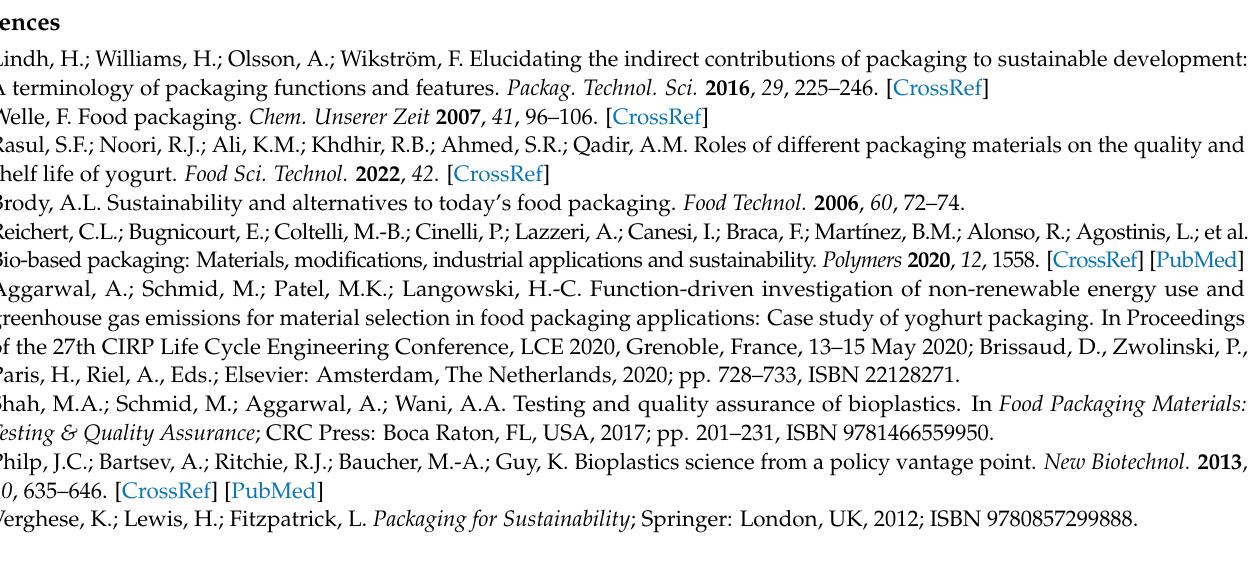
efficiencies related to product weight, Figure S3: Disposal advice on packagings, Table S1: Raw